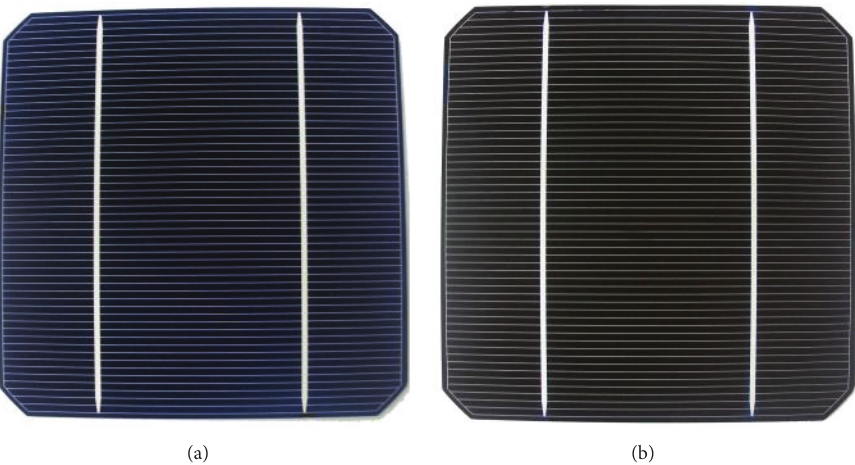
Figure 3: Photographs of monocrystalline silicon solar cells with (a) SiN